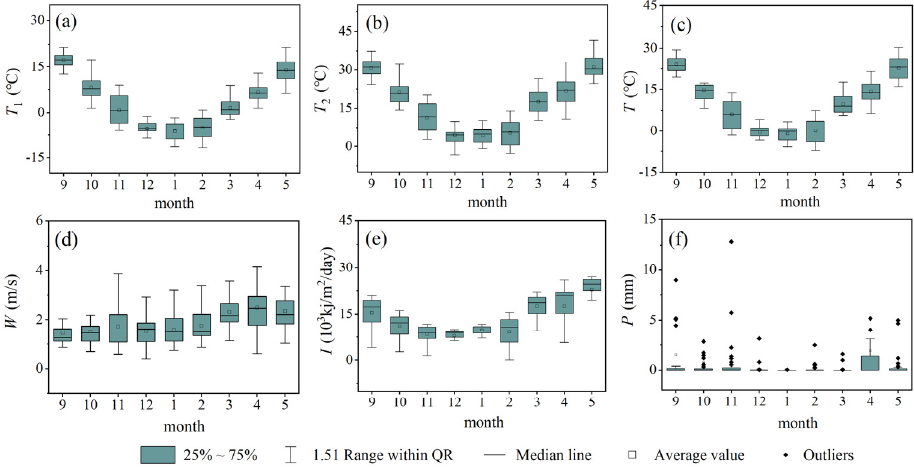
Figure 1. Study location overview map. I: Hebei, Shandong, and Henan low-lying plains; II: pre-mountain plain area in Yanshan and Taihang Mountains; III: Huang-Huai plain area; IV: Shandong hilly area.